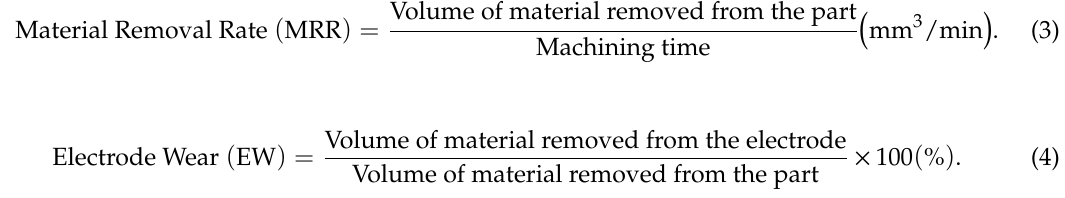
Table 2. Mean values of arithmetical mean roughness (Ra), material removal rate (MRR), and electrode wear (EW), obtained with positive and negative polarity. These values were taken from Reference [2] Torres Salcedo, A.; Puertas Arbizu I.; Luis Pérez, C. J. Analytical Modeling of Energy